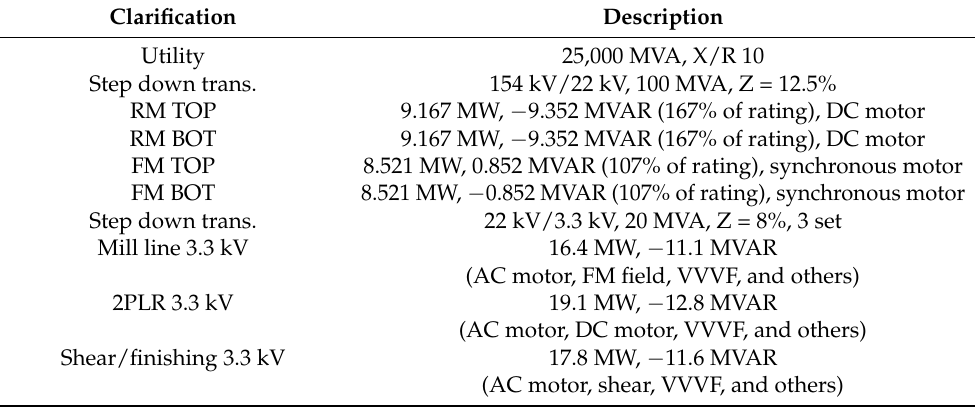
Table 1. Summation of major input data.